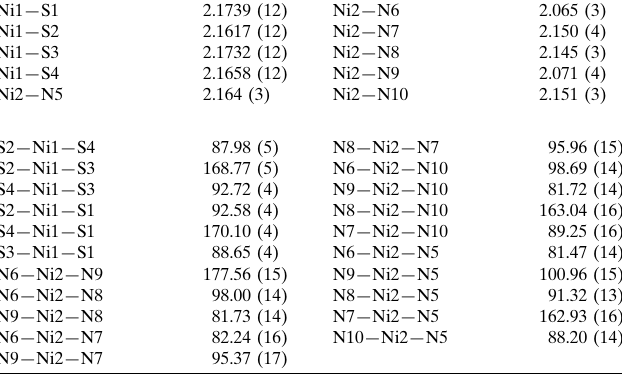
Selected geometric parameters (A˚ , (cid:3) ).